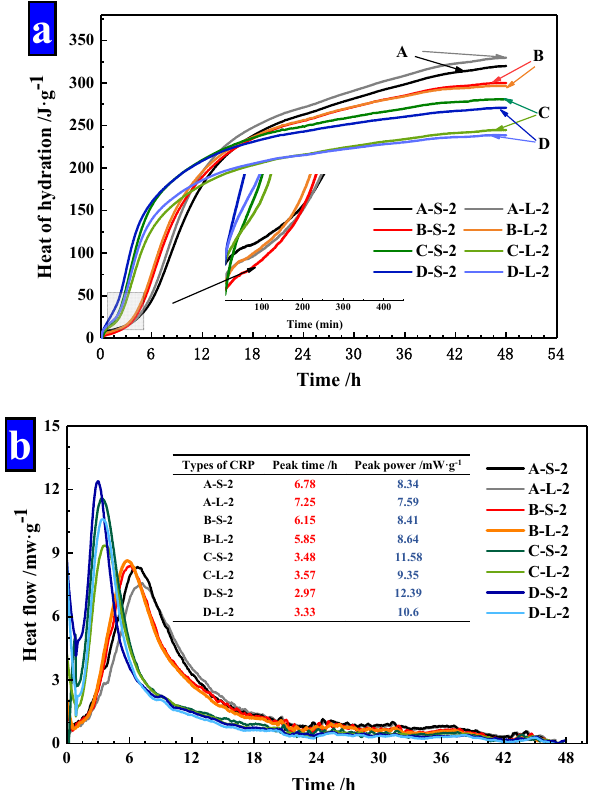
Figure 14. The power and cumulative energy produced per gram of cement for the first 48 h. ( a ) Hydration heat of cement mortar; ( b ) heat flow of cement mortar.